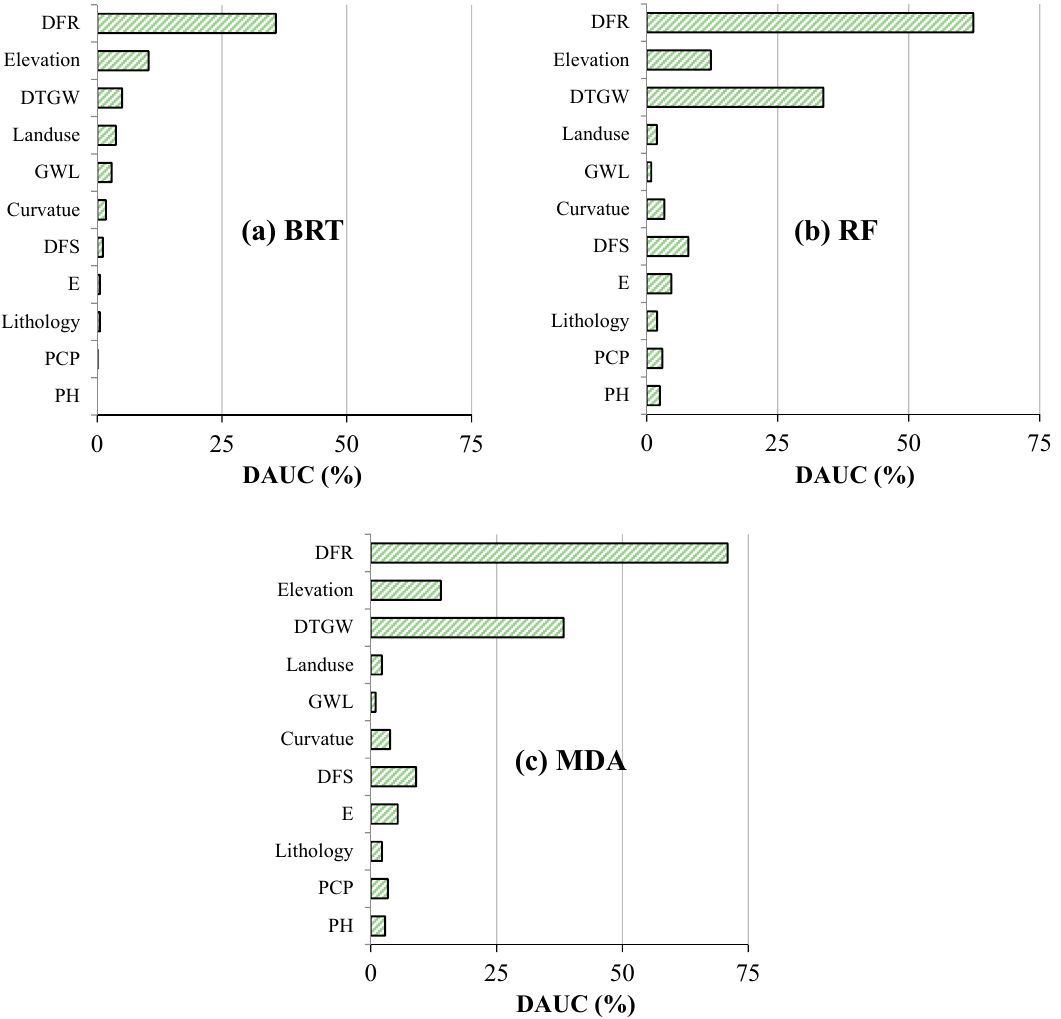
Figure 5. Importance of the input variables.